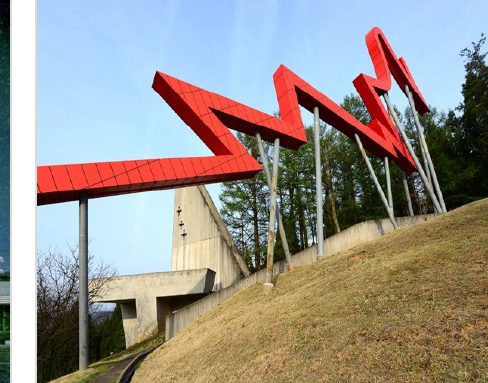
Figure 31 Daniel Libeskind’s object placed deep in the mountains of Toyama prefecture.